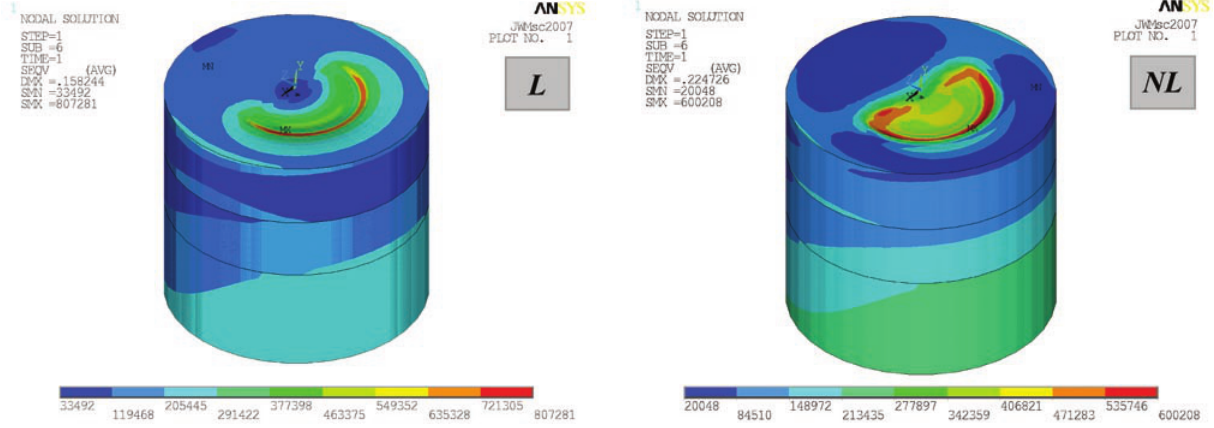
Fig. 8. Stress intensity contours according to von Mises in the layered foundation f H-M , L ( σ ) ∈ [33.492; 807.281], kPa